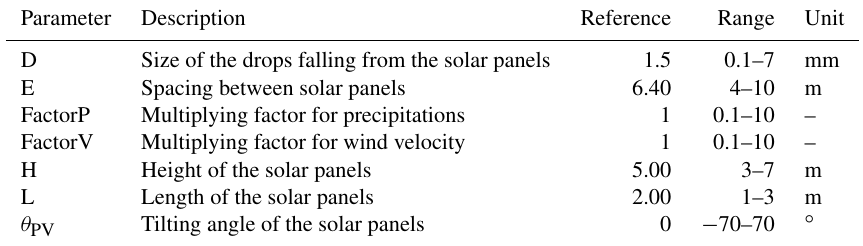
Table 1. Parameters and ranges of values used in the sensitivity analysis of the AVrain model.